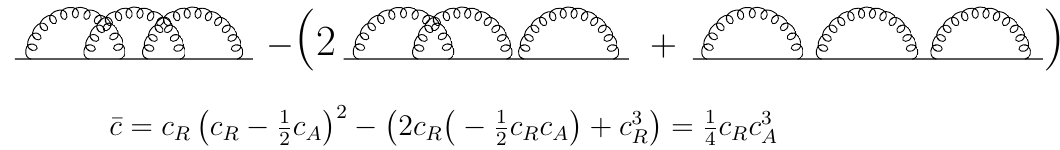
. Their number is given R ( k +1)! k !